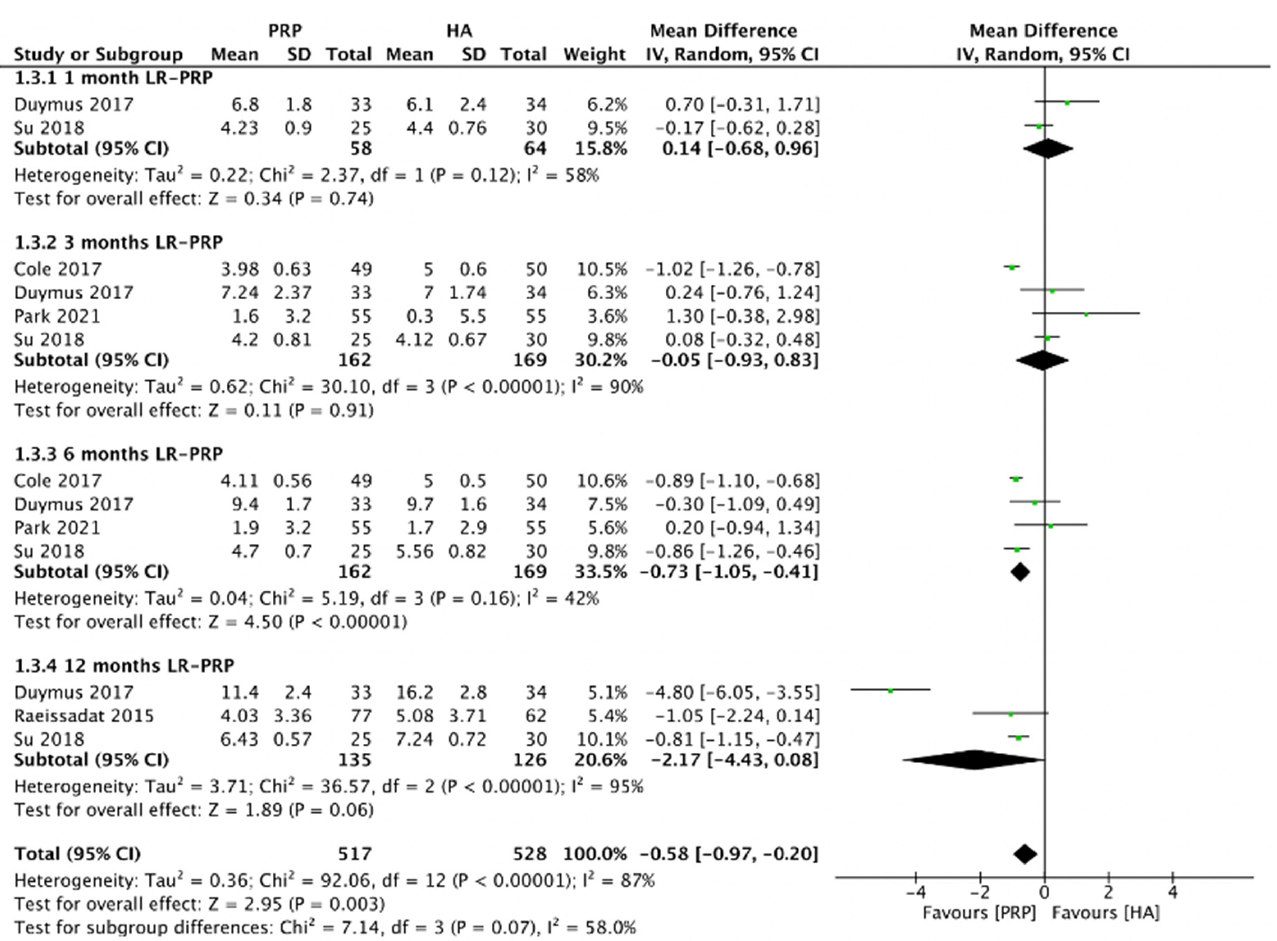
Figure 5. Trials of LR-PRP versus HA. Forest plot of WOMAC pain scores. (IV, inverse variance; CI, confidence interval; SD, standard deviation).